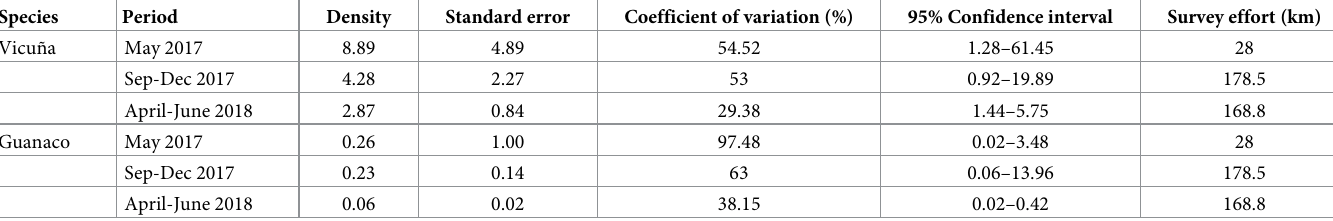
Table 1. Density (individuals/km 2 ) of vicu ñ as and guanacos at San Guillermo National Park, May 2017 –June 2018. Species Period Density Standard